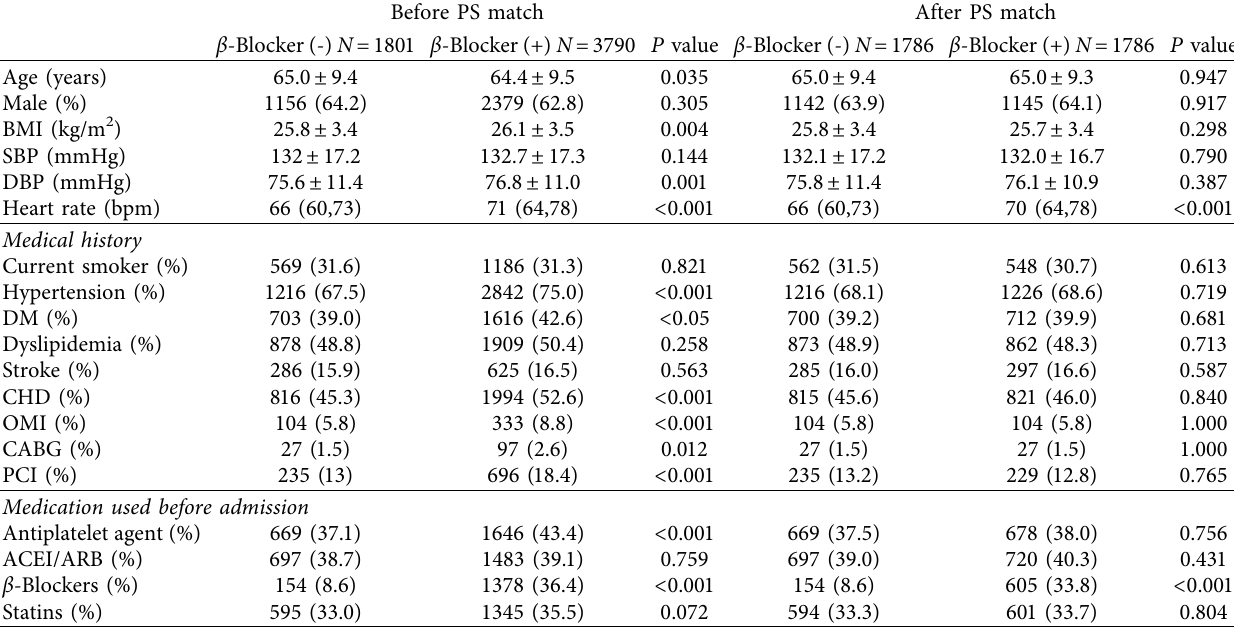
Table 1: Clinical characteristics of patients in the β -blocker and no β -blocker groups. Before PS match After PS